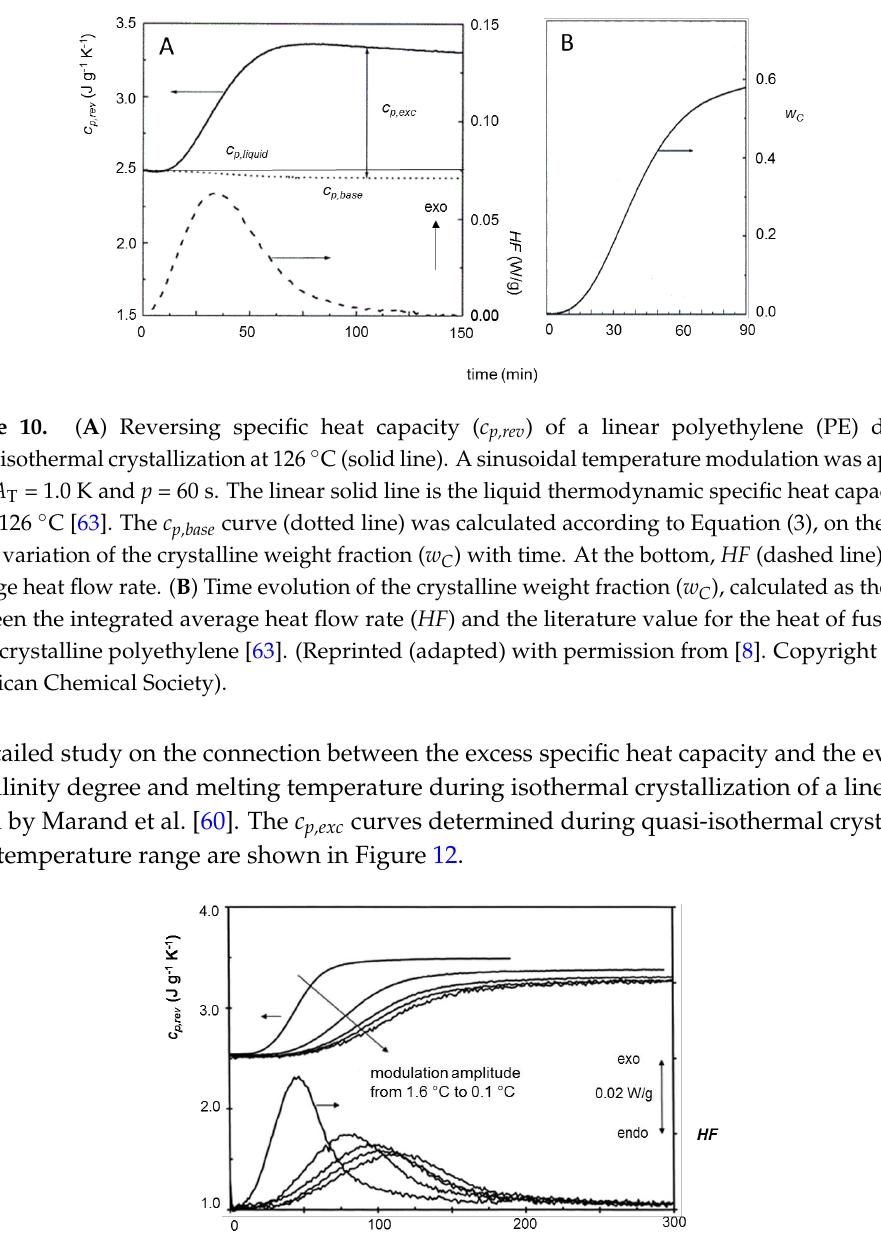
Figure 11. The effect of the modulation amplitude on the quasi-isothermal crystallization of linear PE at 128.5 °C: top: reversing-specific heat capacities ( c p,rev ) curves, bottom: average heat flow rate ( HF ) curves. (Reprinted (adapted) with permission from [26]. Copyright (1999) Elsevier).